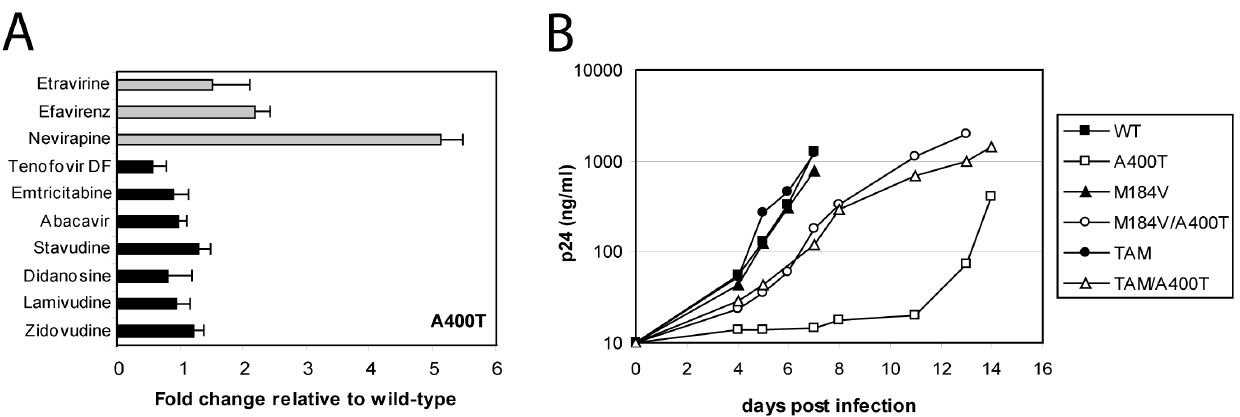
Figure 1. Drug susceptibility and replication of A400T viruses. (A) Susceptibility of the A400T virus to NNRTI (light grey) and NRTI (dark grey) was measured using single-cycle drug susceptibility assays. The average of three independent experiments is plotted, and the standard deviation is shown (error bars). The susceptibility of the A400T virus is shown as the relative difference in IC 50 compared to the wild-type pNL4.3-XN virus. (B) Replication of viruses containing A400T alone, or in combination with M184V or TAMs. SupT1 cells were infected with an equal amount of virus (50 ng). CA-p24 production was measured in the culture medium at several days post infection. A representative experiment is shown. Three independent experiments were performed with similar results.